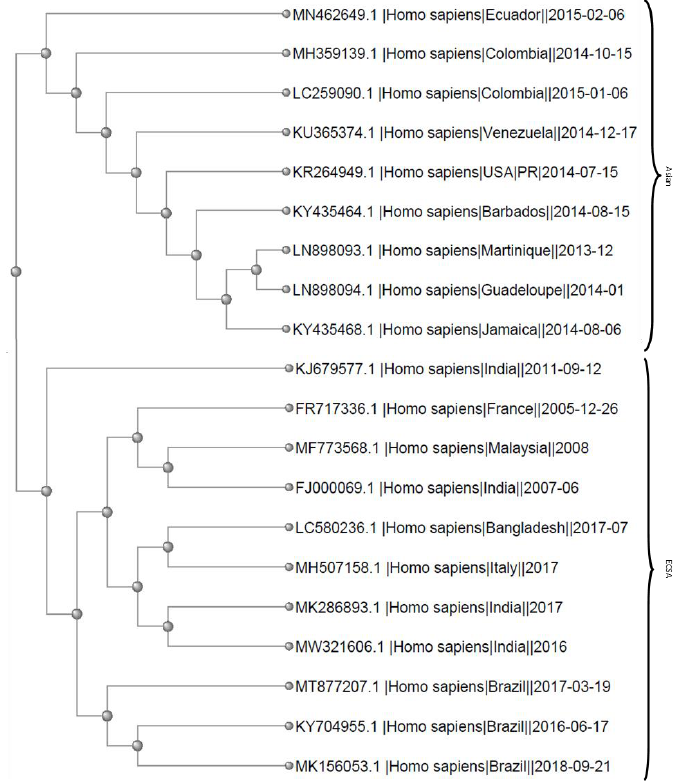
Figure 2. Phylogenetic tree showing strains of CHIKV taken from Homo sapiens samples that were obtained at the same location during the outbreaks in which altered cardiac status was reported. The strains and tree were developed using the NCBI viruses software [23].